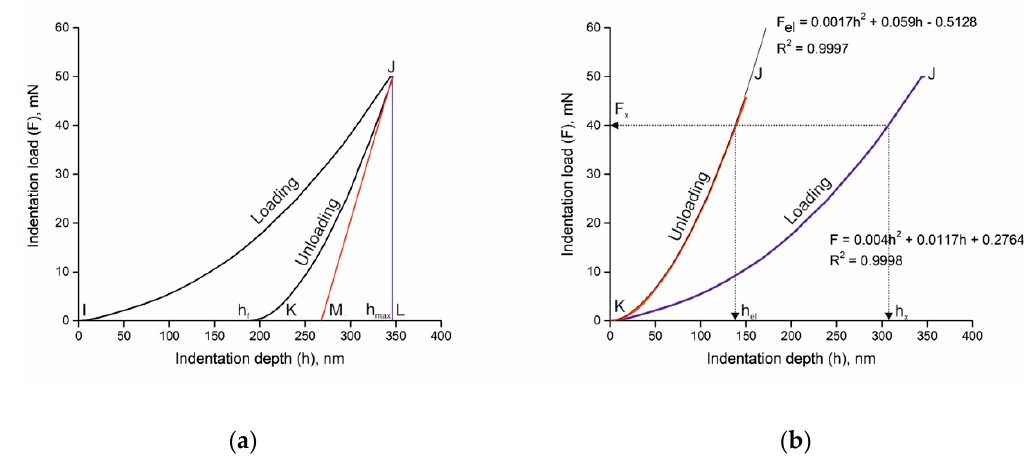
Figure 1. Indentation curve schematics: indentation curve of Ti 3 SiC 2 MAX phase of specimen SPSed at 1350 °C ( a ) and approximation and calculation of indentation parameters ( b ).